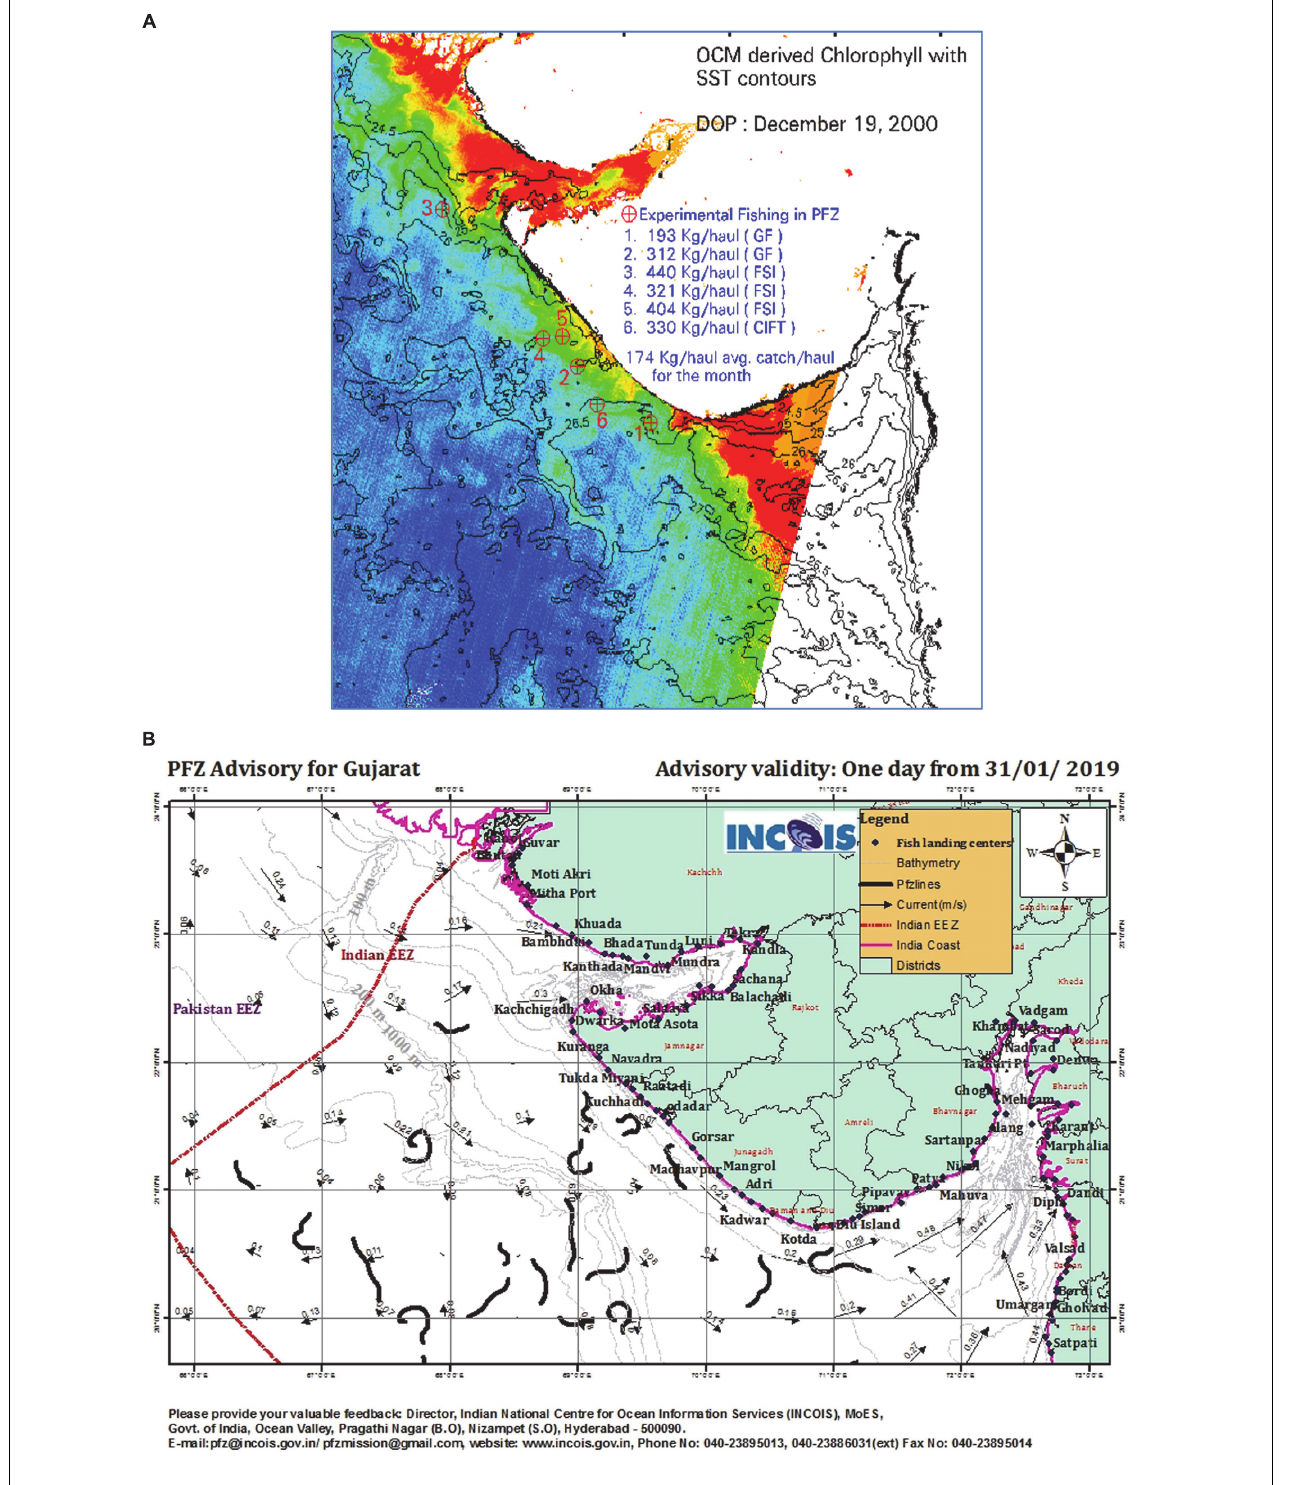
FIGURE 6 | (A) Ocean Colour Monitor-derived chl-a concentration with overlaid SST contours used to find PFZ regions. (B) Example PFZ advisory issued by INCOIS, Hyderabad on a routine basis for the Orissa coast of India showing both potential fishing zones (noted as ‘Pfzlines’) as well as restricted fishing areas (‘Restricted_zones’). Such advisories are provided for the entire Indian coastline (Credit: INCOIS, Hyderabad; see https://incois.gov.in/MarineFisheries/PfzAdvisory).